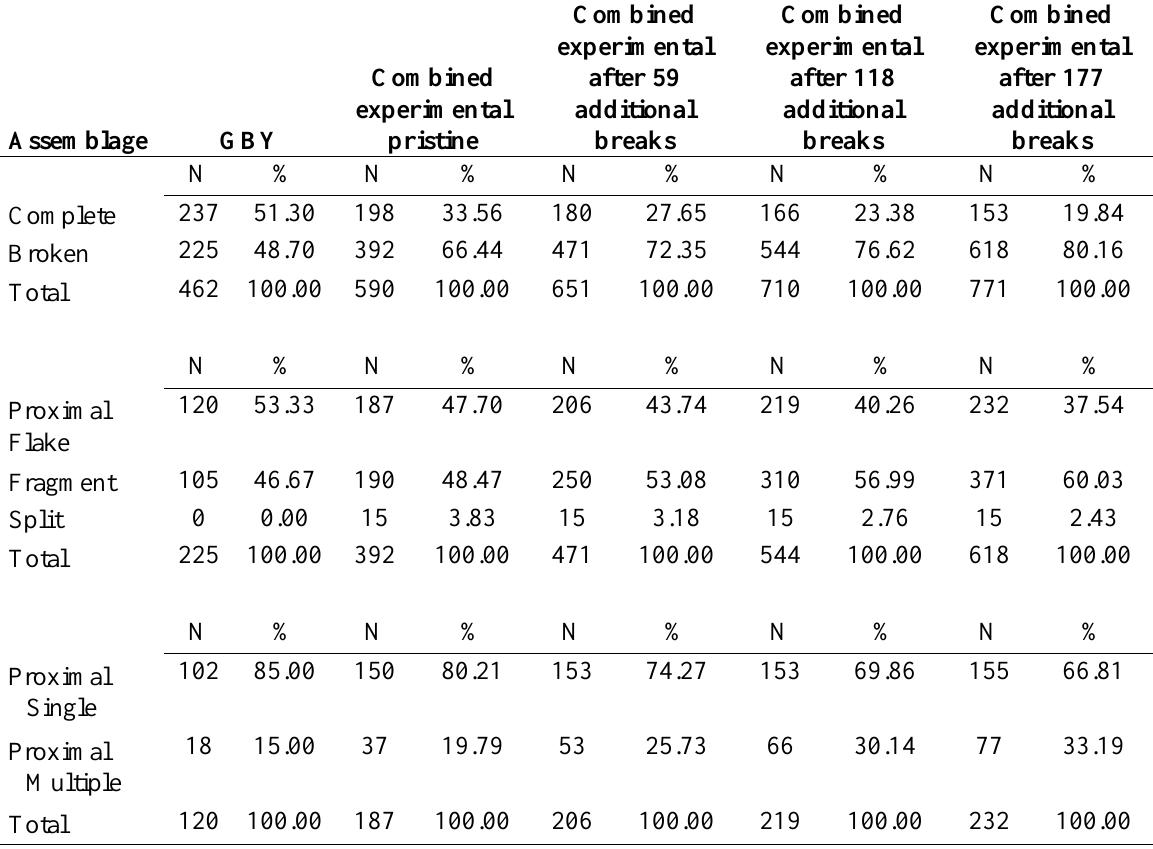
Table 4. Breakage assemblages described by hierarchical classification of archaeological, experimental and post- depositional simulation. Assemblage GBY